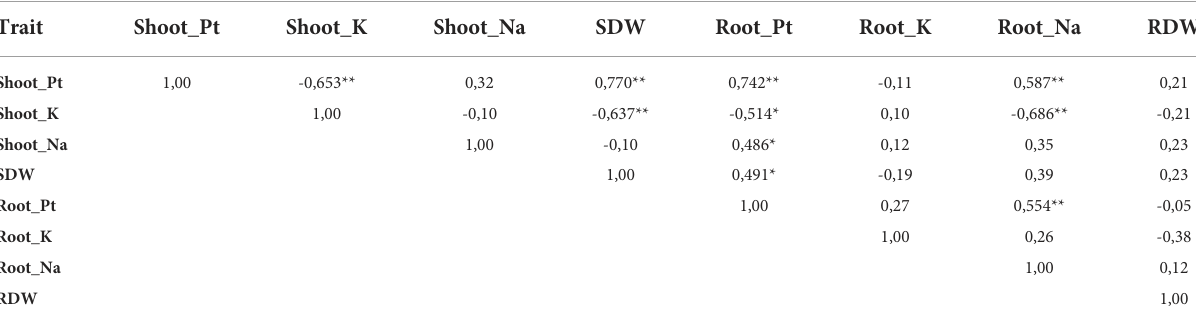
TABLE 2 Pearson ’ s correlation coef fi cients among plant dry weight (shoot and root dry weight) and measured nutrients in the shoot and root of wheat plants grown with different forms and doses of soluble P-fertilizers under salinity at 12 WAS (n = 24). Pearson ’ s correlation coef fi cients